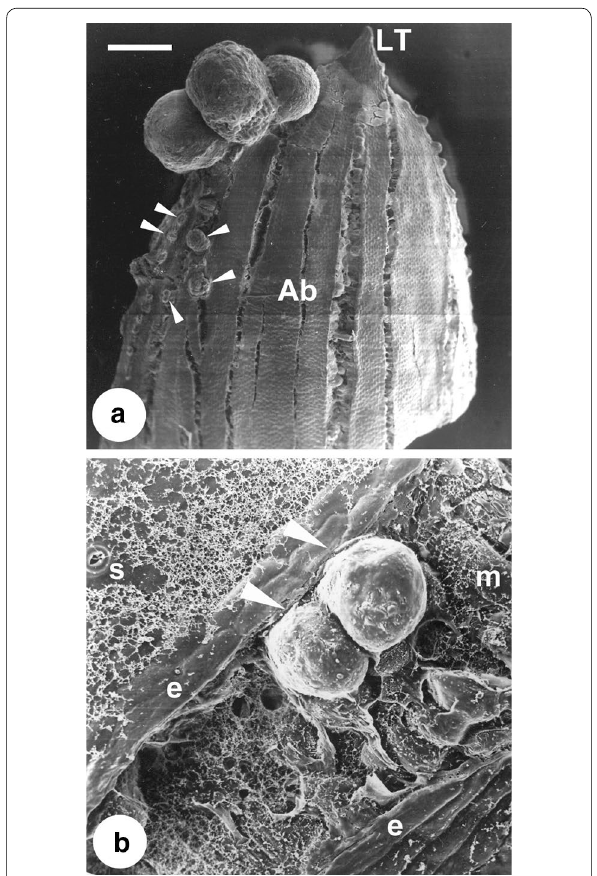
Fig. 1 Scanning electron microscopic observations on direct somatic embryogenesis from leaf explants of Tolumnia Louise Elmore ‘Elsa’. a somatic proembryos (SPE, < 0.5 mm in diameter) and globular embryos (SGE, > 0.5 mm in diameter) formed from the leaf cells ( Scale bar 1.5 mm); b a SPEs formed from the mesophyll cells ( Scale bar 100